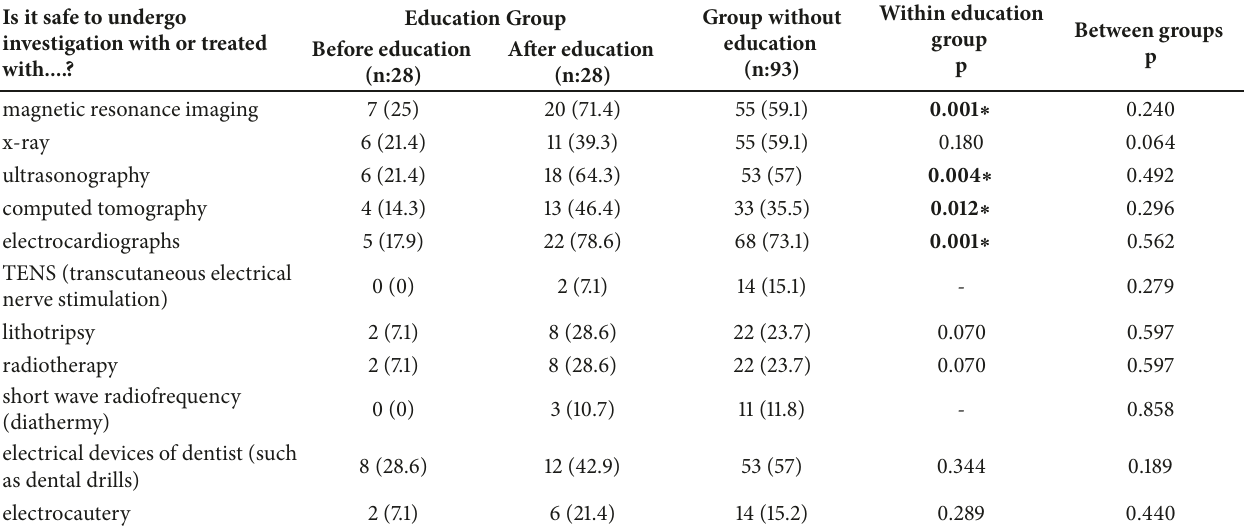
Table 6: Correct responses of patients on safety of medical devices for electromagnetic interference with cardiac implantable electronic